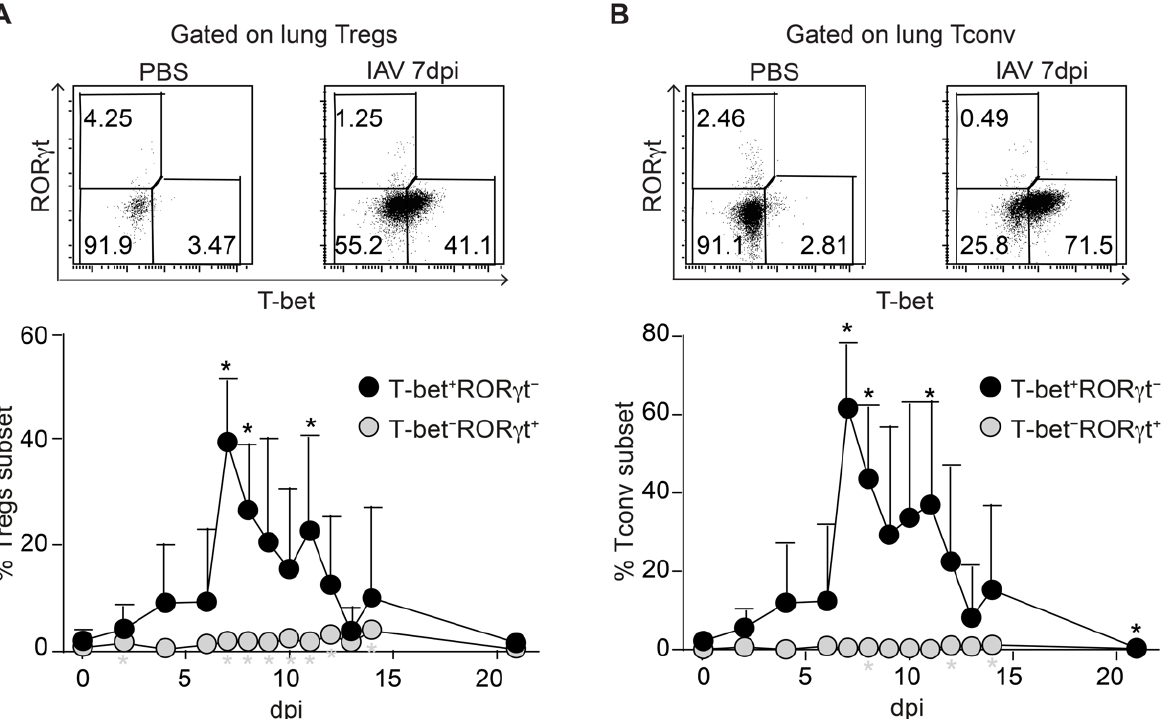
Figure 3. Lung Tregs show a dominant T-bet + phenotype during IAV infection. Foxp3 hCD2 × Rag1 GFP reporter mice were infected with IAV and analyzed at indicated dpi. Lungs were collected and prepared, and single-cell suspensions were restimulated and subsequently analyzed by flow cytometry. ( A ) Representative dot plots depict T-bet and ROR γ t frequencies among gated Foxp3 hCD2+ Tregs from lungs of PBS-treated and IAV-infected mice (7 dpi). The graph summarizes frequencies of T-bet + ROR γ t − Tregs (black filled circles) and T-bet − ROR γ t + Tregs (gray filled circles) in lungs collected from IAV-infected mice at the indicated dpi; ( B ) Representative dot plots depict T-bet and ROR γ t frequencies among gated Tconv from lungs of PBS-treated and IAV-infected mice (7 dpi). The graph summarizes frequencies of T-bet + ROR γ t − Tconv (black filled circles) and T-bet − ROR γ t + Tconv (gray filled circles) in lungs collected from IAV-infected mice at the indicated dpi. Data were pooled from two independent experiments, which included 5–9 mice per group, and presented as mean + SD. Mann–Whitney test was used to calculate statistical significance by comparing values from untreated animals (0 dpi) with values from IAV-infected mice (2 to 21 dpi). Significant changes are indicated by an asterisk.